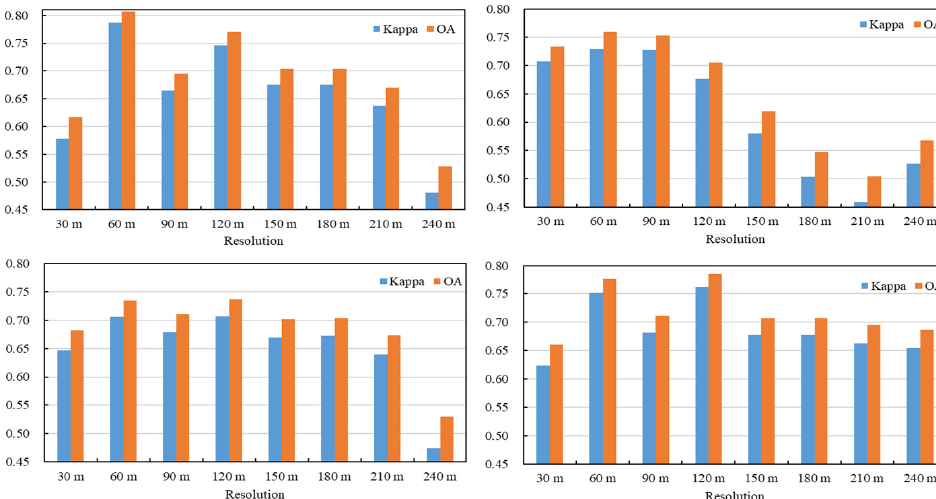
Figure 3. Accuracy of LCZ classification results at different resolutions.